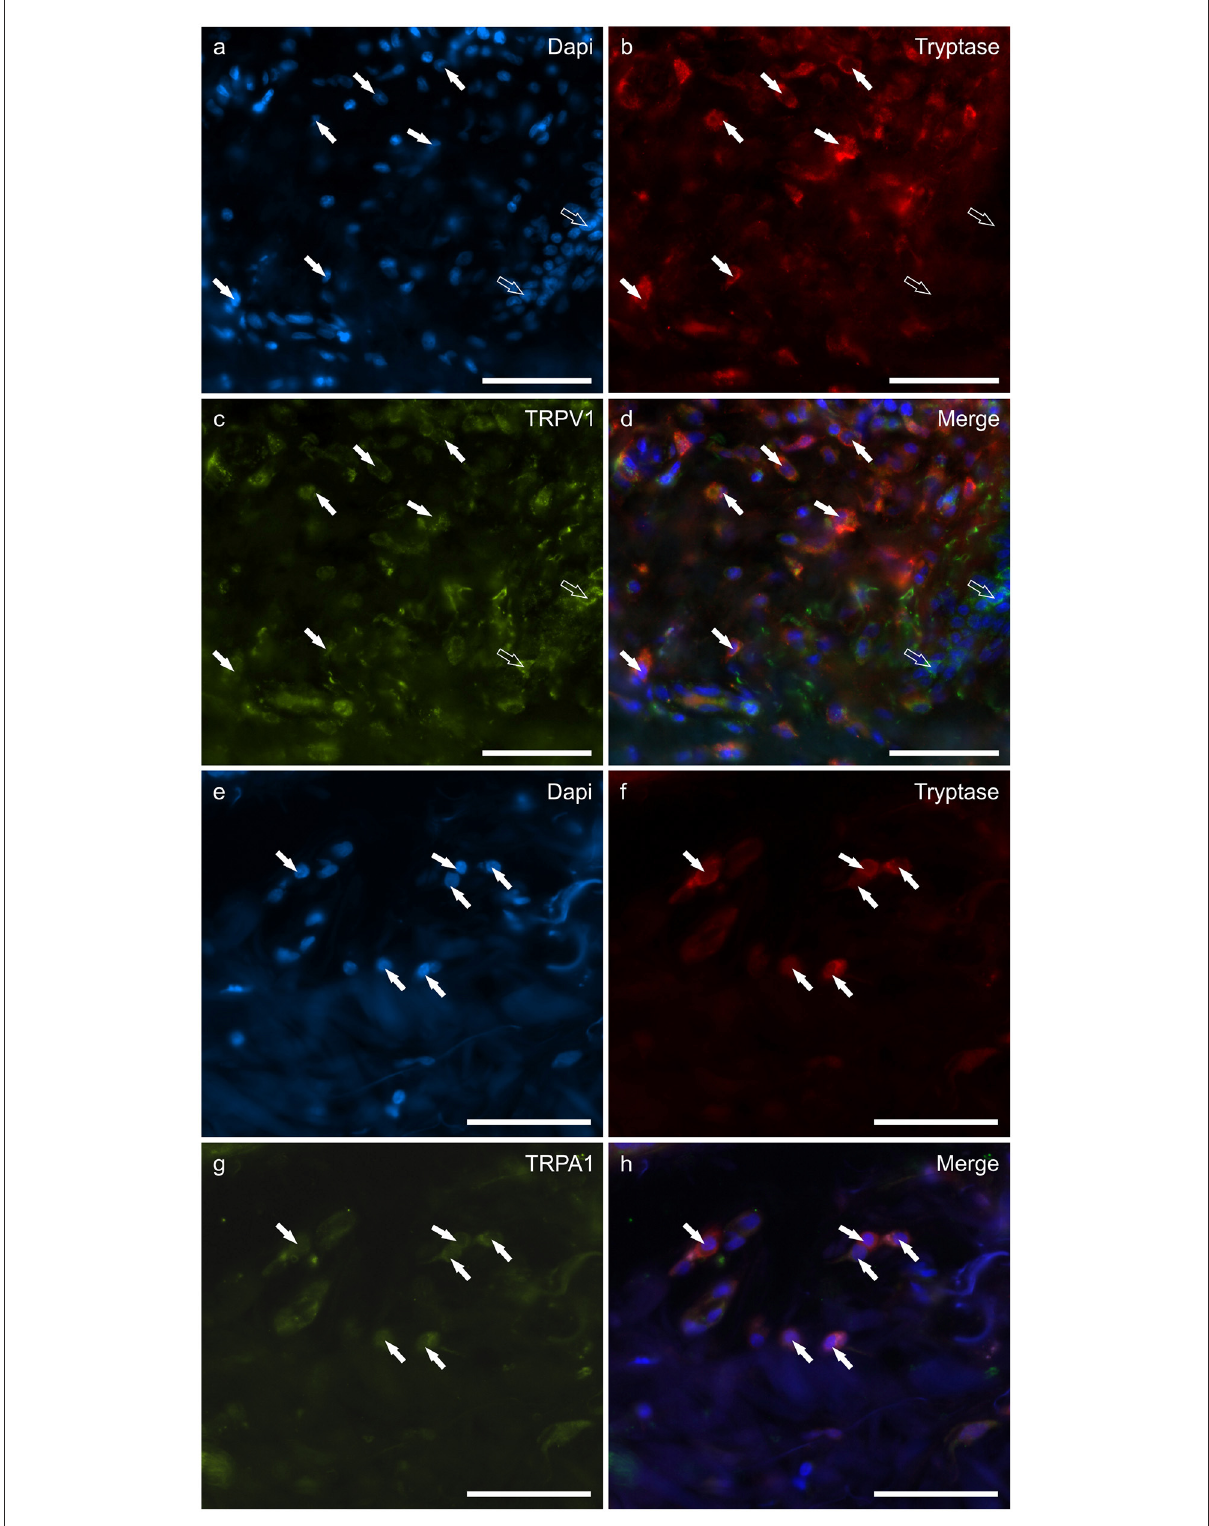
FIGURE2 Photomicrographs of the cryosections of the skin of dogs with atopic dermatitis (AD) showing tryptase immunoreactive mast cells (MCs) expressing transient receptor potential vanilloid 1 (TRPV1) (a–d) and transient receptor potential ankyrin 1 (TRPA1) (e–h) immunoreactivity (IR). The white arrows indicate the Dapi-labeled nuclei of tryptase positive MCs co-expressing TRPV1- (c) and TRPA1-IR (g) . The open arrows indicate some tryptase negative cells of the dermis which expressed TRPV1-IR (c) . Bar: 50 µ